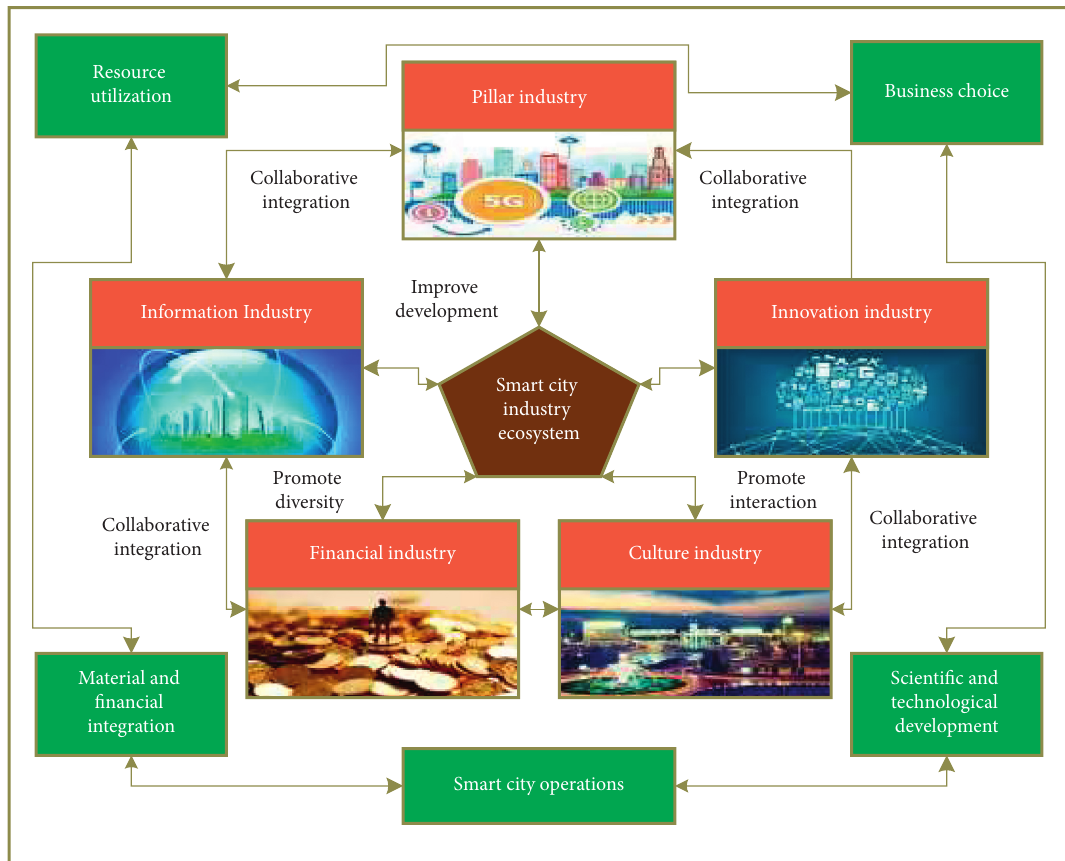
Figure 3: Smart city industrial